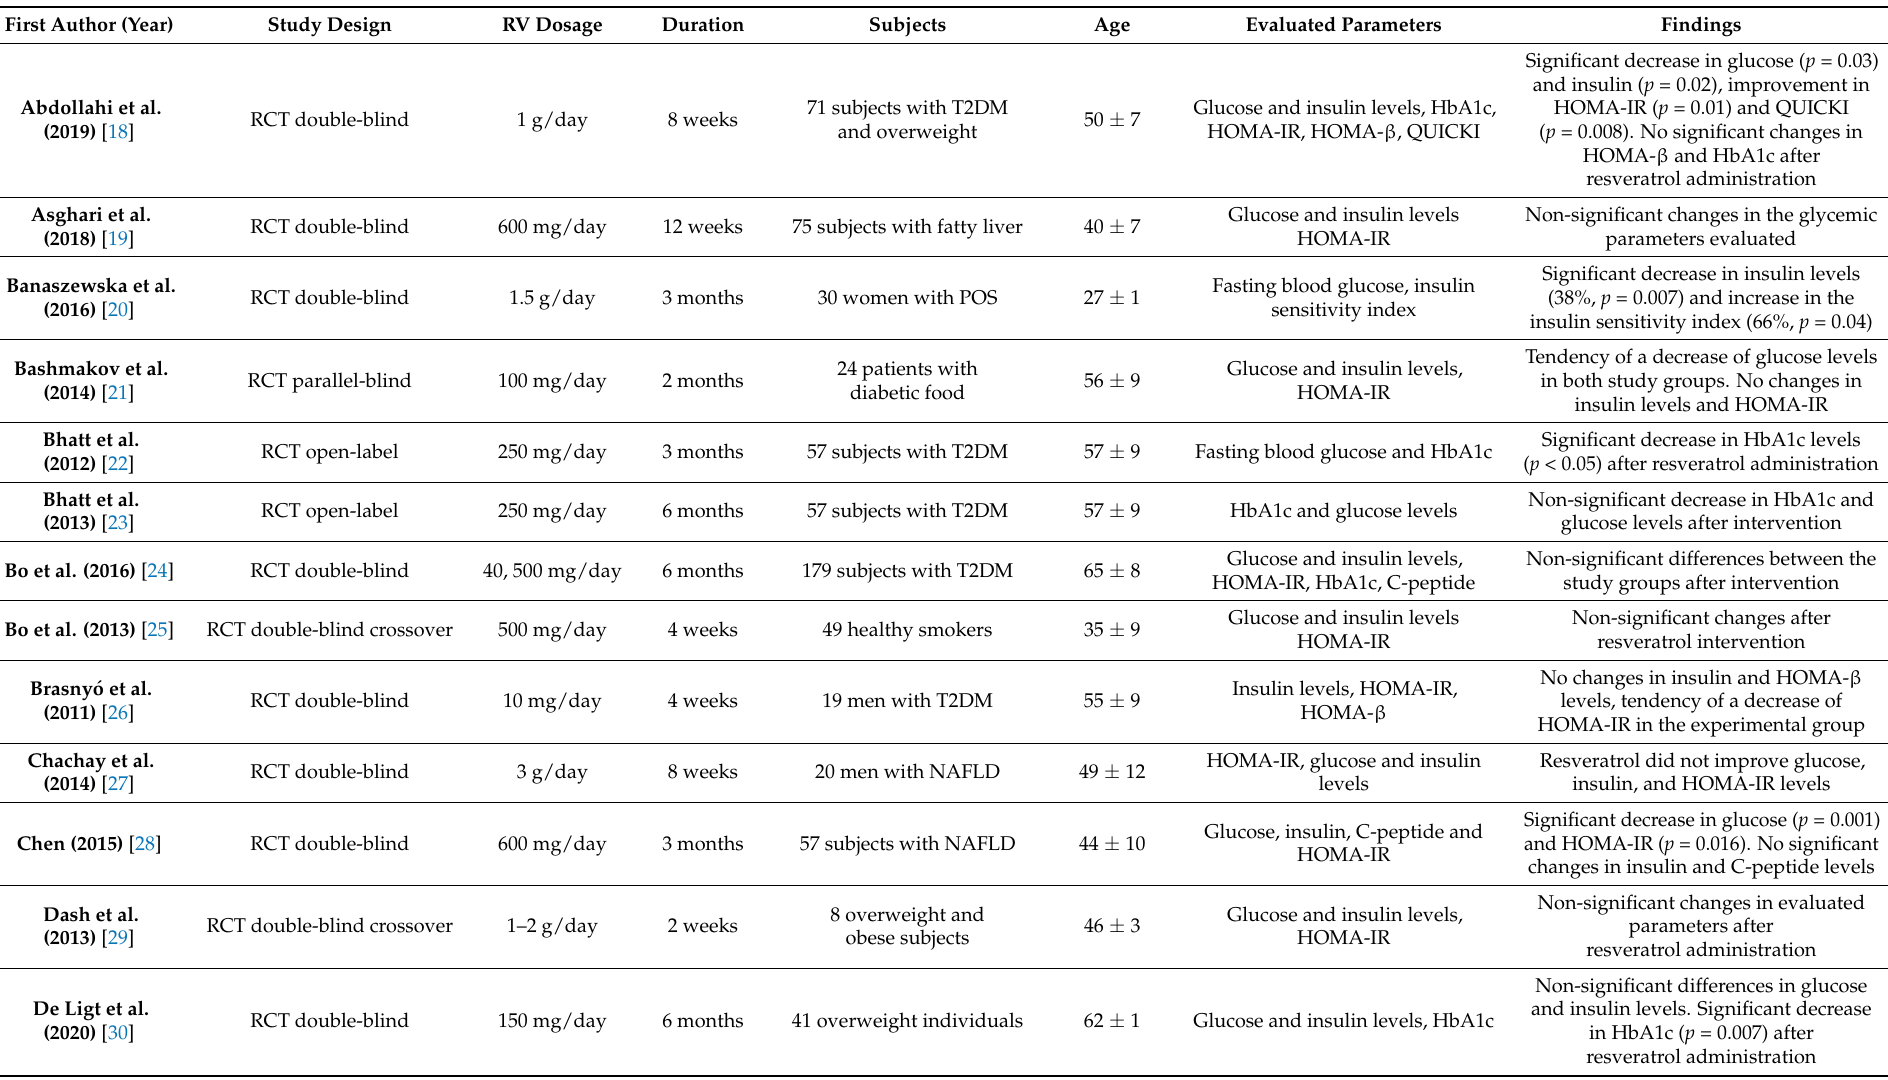
Table 1. Characteristics of clinical trials included in the